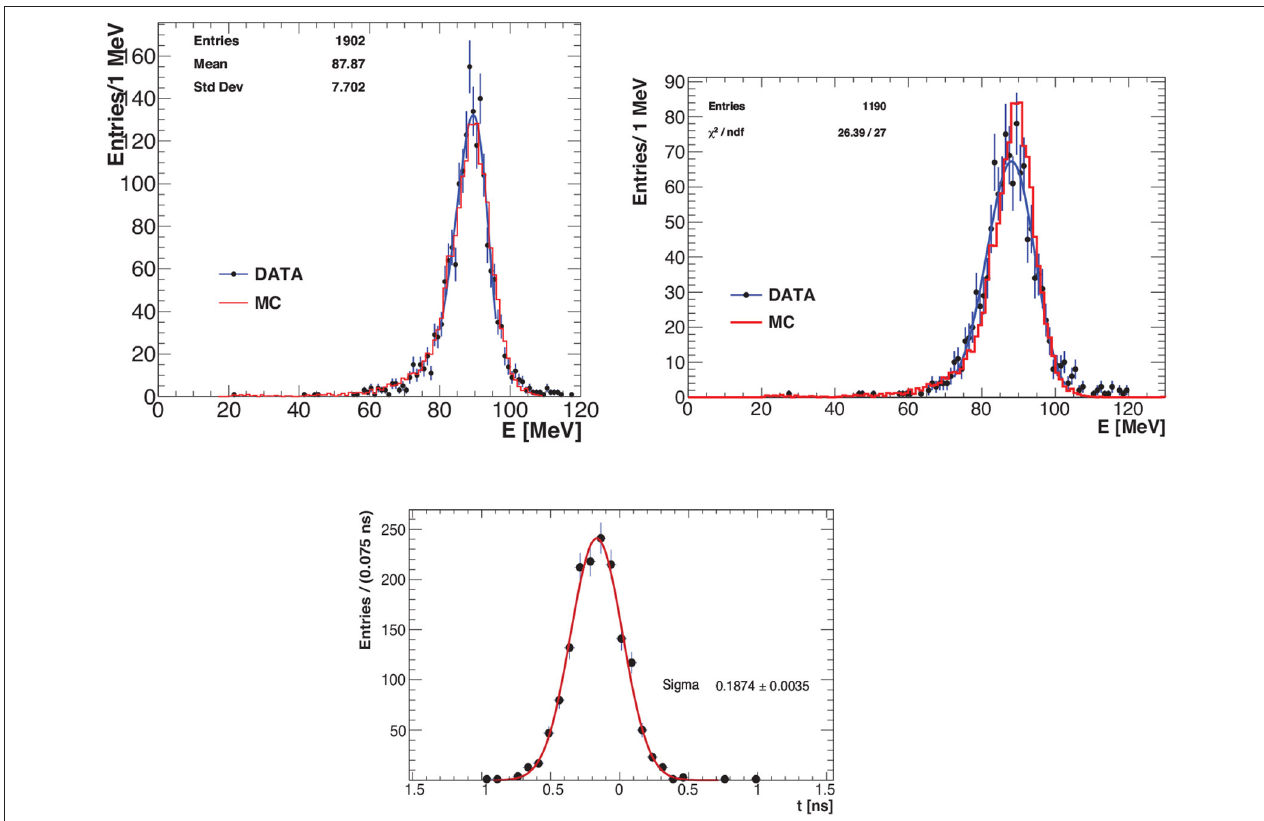
FIGURE 15 | The energy and time resolution of the test module for the Mu2e calorimeter for electrons at the conversion energy. The top left is for electrons striking the array at normal incidence; the top right, for 55 ◦ to the face. A simulation, using measured properties to tune GEANT4, is shown, indicating good agreement.